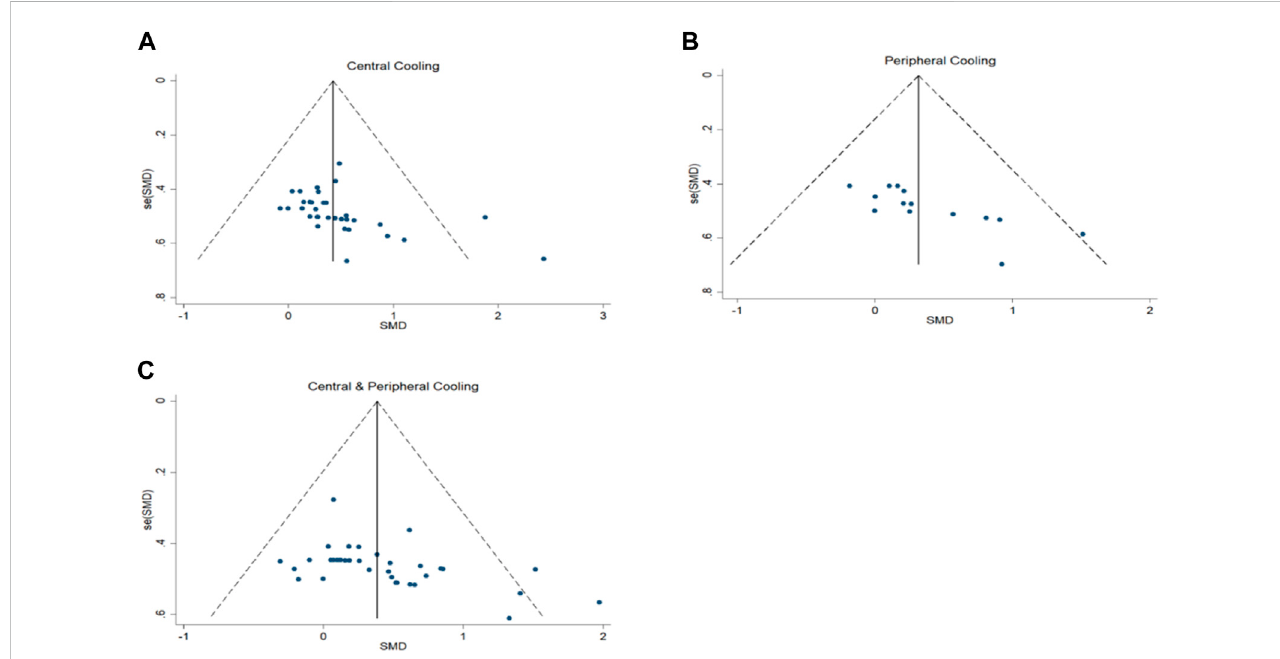
FIGURE 4 Forest plot regarding the effects of peripheral cooling on athletic